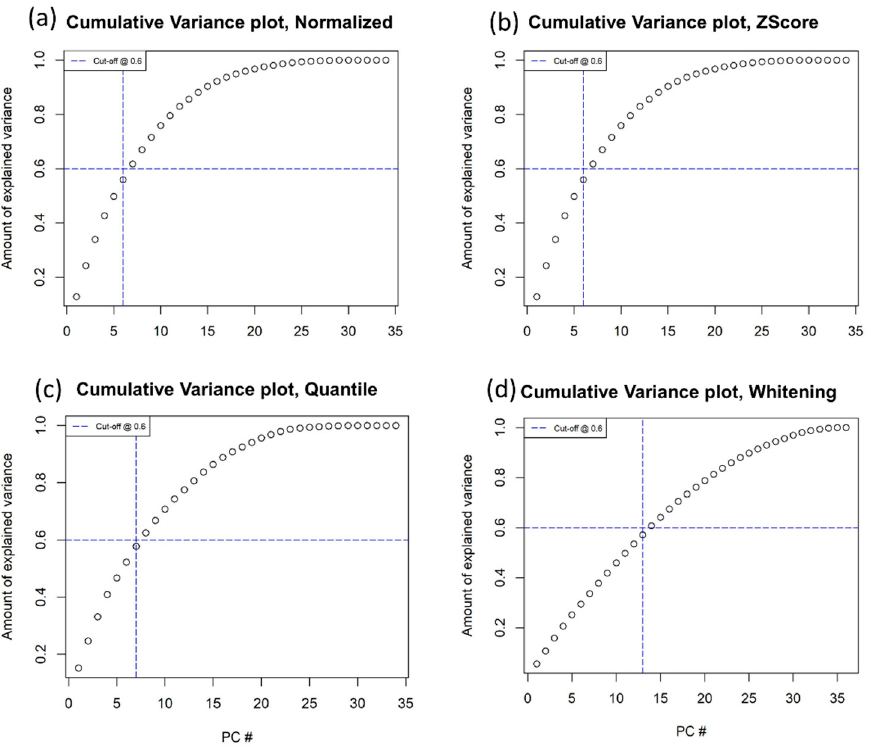
Figure 3. Cumulative variance plots for the 4 datasets, based on a threshold of 0.6. ( a ) Normalized only as the ratio of malignant and healthy radiomic features; ( b ) Z-Score; ( c ) quantile; and ( d ) whitening.